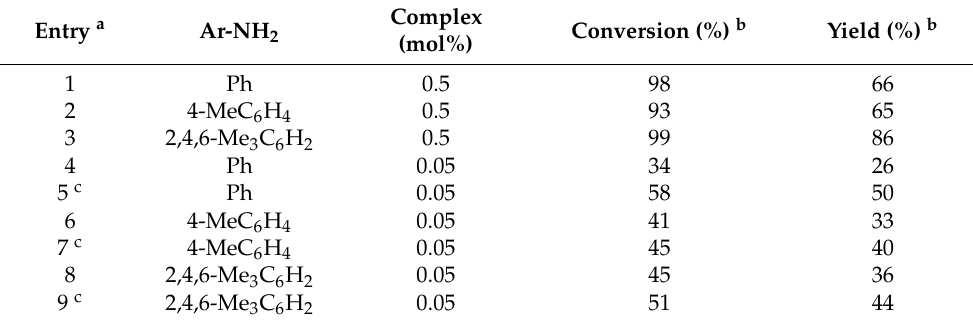
Table 10. Hydroamination of phenylacetylene with substituted Table 10 . Hydroamination of phenylacetylene with substituted anilines.